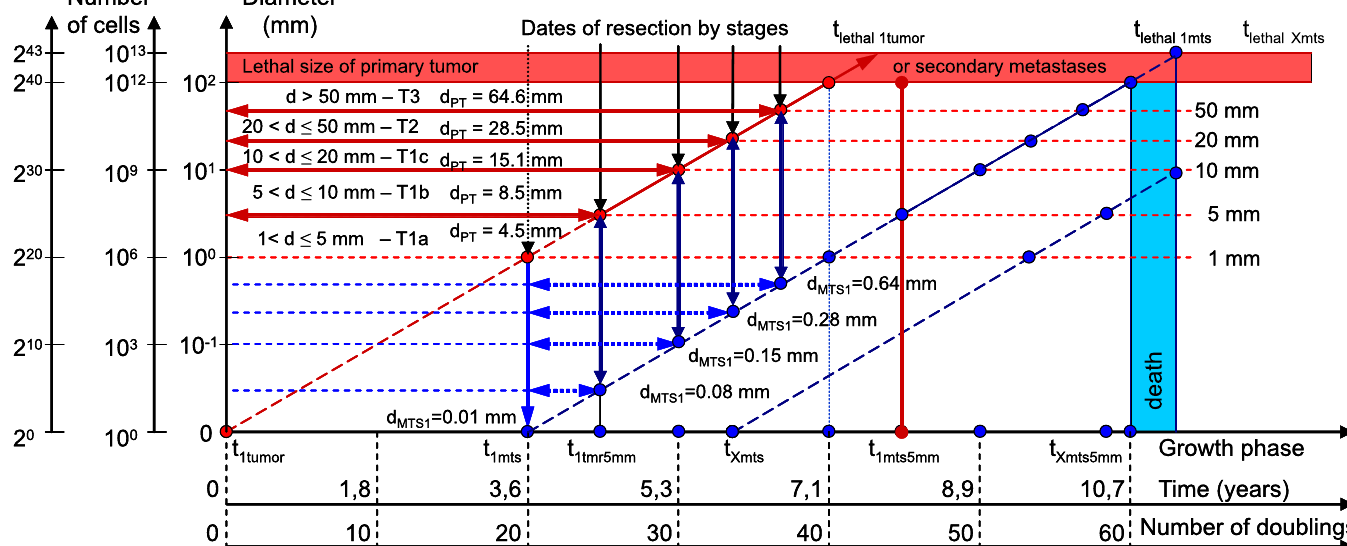
Fig 8. The size of secondary distant MTS. The diameter was in range of 0.08 mm and 0.64 mm at surgery date of PT (diameter below diagnostic level).